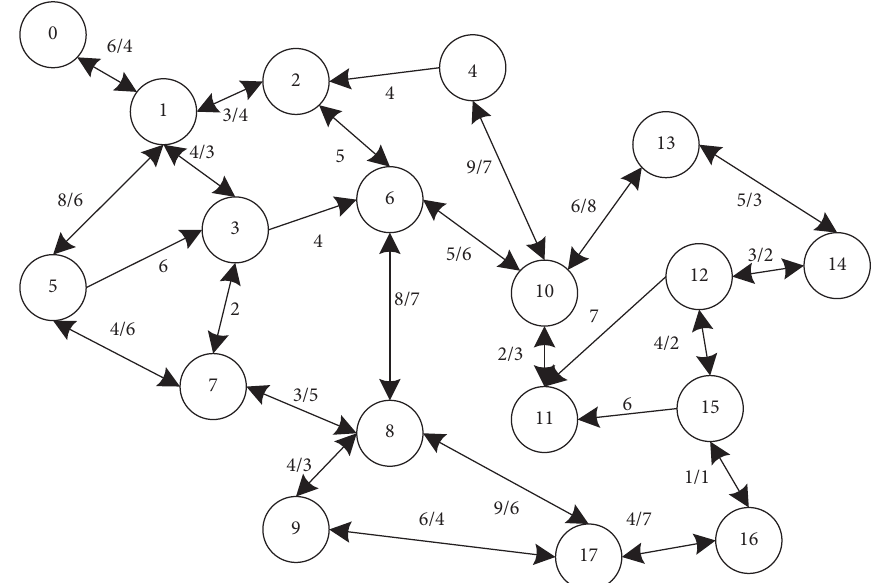
Figure 1: Abstract diagram of the route of the key intersection of urban traffic at a certain moment.